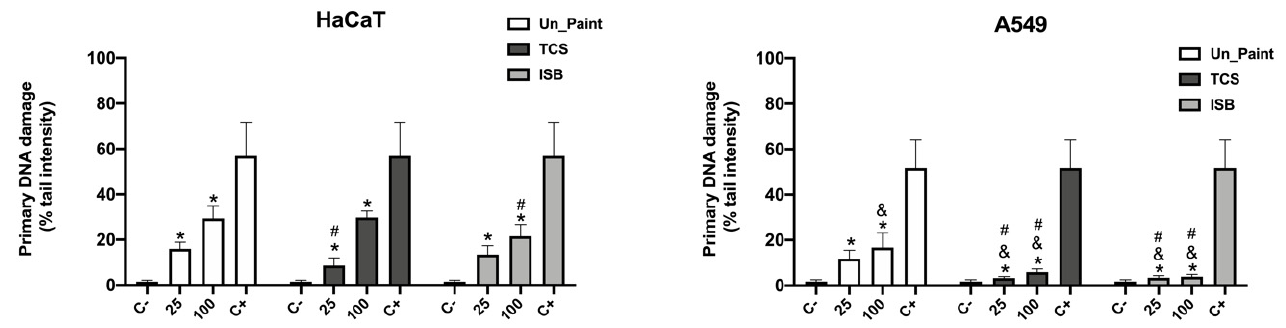
Figure 5. Results of alkaline comet assay, with HaCaT (left) and A549 (right) cell lines, after exposure to the extracts (in the x axis) of Un_Paint, TCS or ISB extracts for 24 h. C- negative control (complete medium), C+ positive control (MMS 800 µM solution). The values are expressed as mean ± standard deviation. The statistical significance of samples compared to C- is represented by * (One-way ANOVA; p < 0.05). The statistical significance of samples compared to Un_Paint is represented by # (Two-way ANOVA; p < 0.05). The statistical significance of the extract on A549 cells compared to the same extract, in the same concentration, on HaCaT cells is represented by & (Two-way ANOVA; p < 0.05).